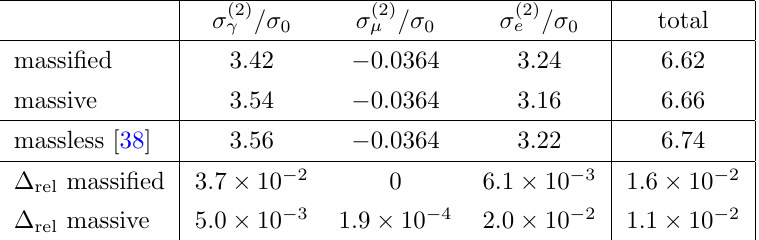
Figure 3 . The (cid:24) c (in)dependence of the ( (cid:15) 0 coe(cid:14)cient of the) double-real corrections for two 2 (cid:24) c . The d (cid:27) (2) -data (blue, data and (cid:12)t), d (cid:27) (2) ss (yellow) and 1 hh 1 (green) sum up to the total n + 2 particle contributions (red). The right panel magni(cid:12)es the region of interest including 1 (cid:27) bounds. Note that the swap c 1 $ c 2 is trivial. All plots are normalised such that h d (cid:27) (2) rr ( (cid:24) c ) i = 1. 2